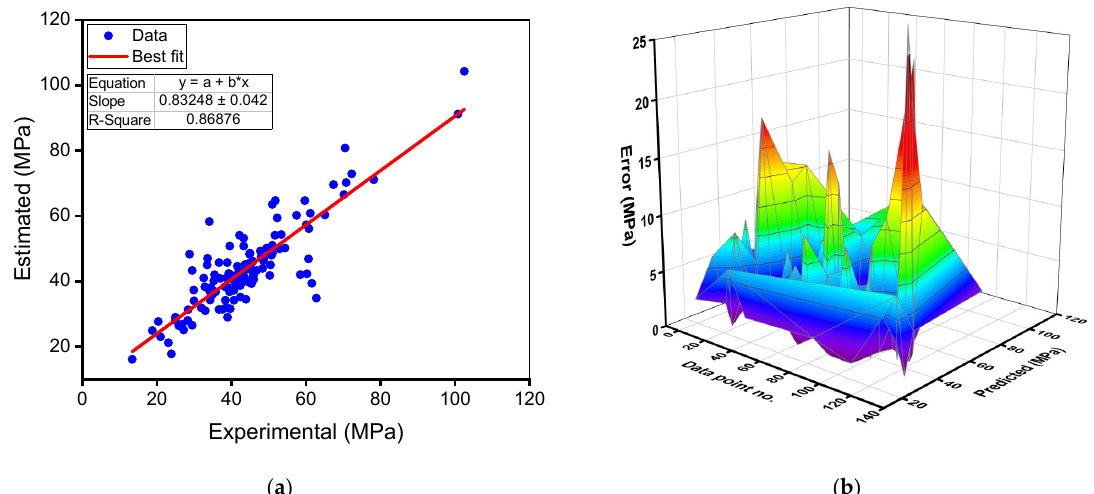
Figure 6. Gradient boosting model for compressive strength: ( a ) relationship between experimental and predicted results; ( b ) spreading of predicted and error values.